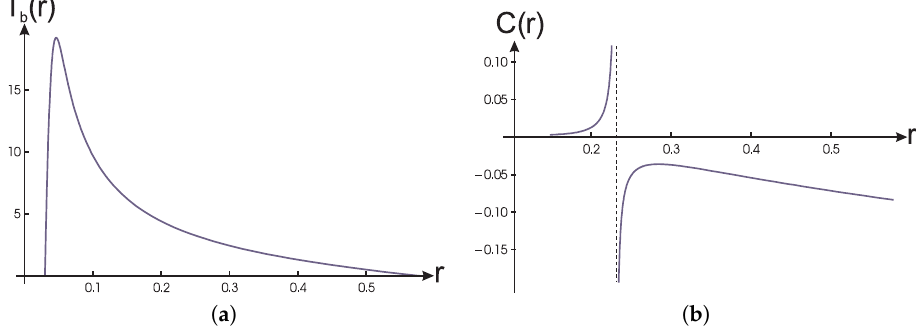
Figure 4. Temperature ( a ) and specific heat ( b ) of the black hole